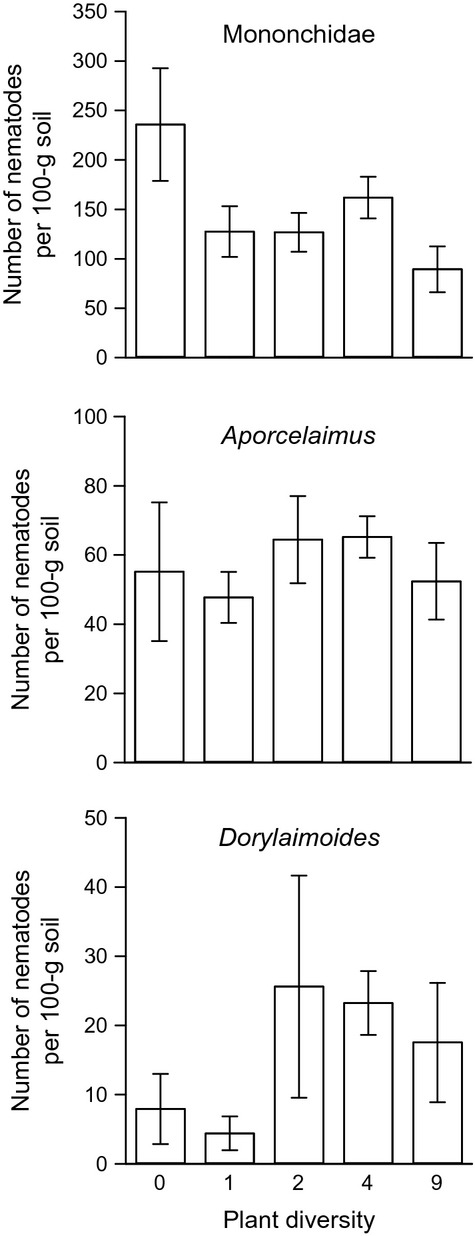
Effect of plant diversity on the abundance of carnivorous nematodes of family Mononchidae and genera Aporcelaimus and Dorylaimoides. The number of nematodes was calculated per 100 g dry weight soil.